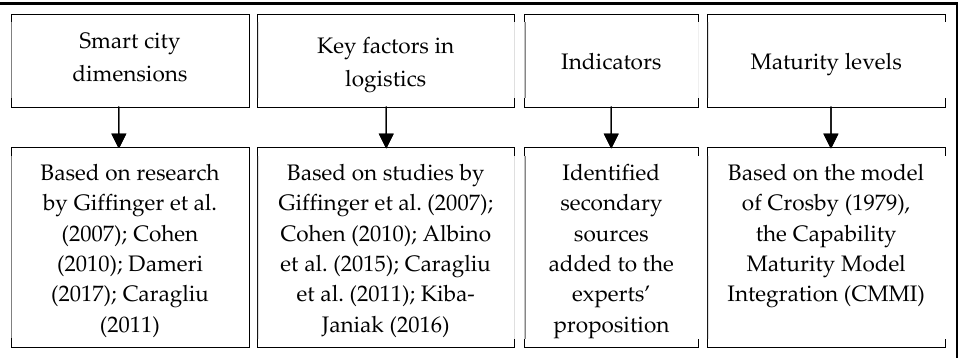
Figure 2. Summary of the research instrument’s rationale.